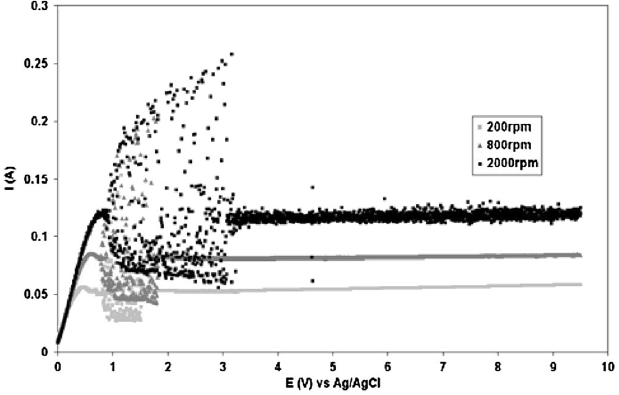
FIG. 2. I(V) curves at different rotation speeds for mixture